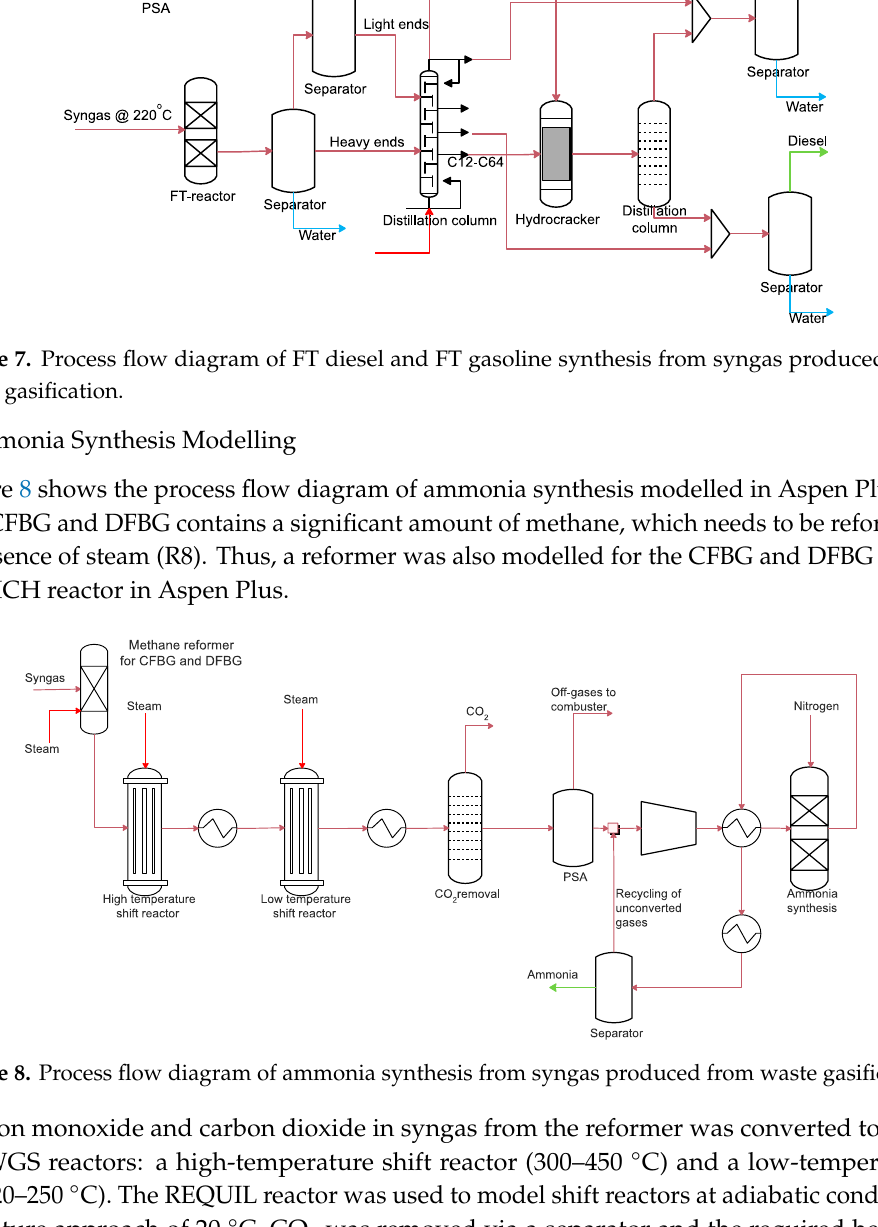
Figure 7. Process flow diagram of FT diesel and FT gasoline synthesis from syngas produced from waste gasification.